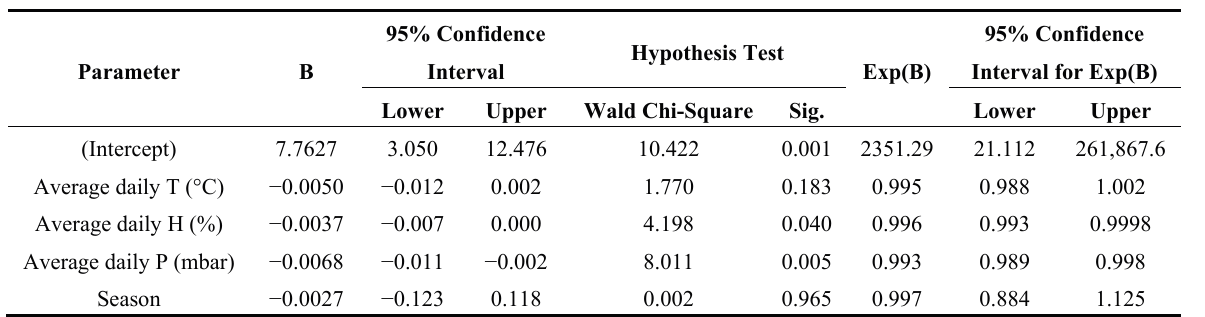
Table 2. Daily ACS incidence for population under